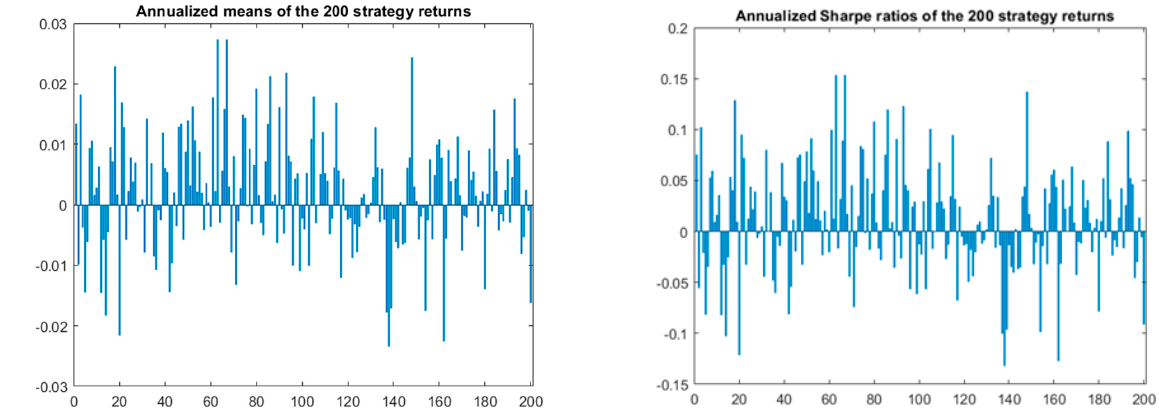
Figure 20. The modified annualized mean returns and Sharpe ratios of the 200 strategies.